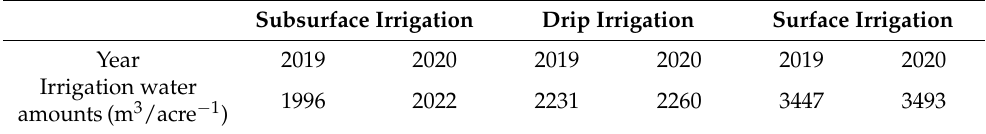
Table 2. Calculated irrigation water amounts (m 3 /acre − 1 ) based on irrigation systems of green bean. Subsurface Irrigation Drip Irrigation Surface